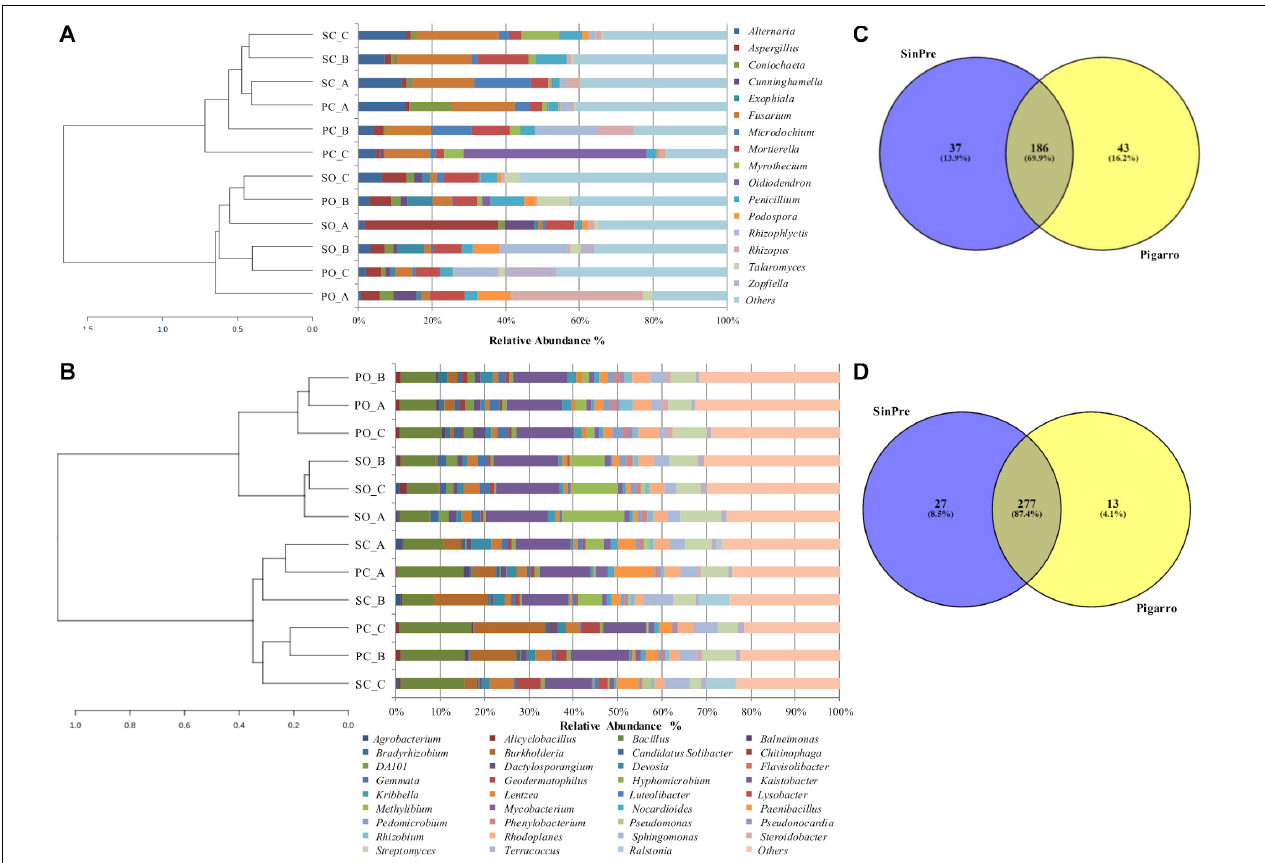
FIGURE 2 | Relative abundance of different fungal (A) and bacterial (B) genera in the soil rhizosphere in both populations representing the genera showing more than 1% relative abundance of all reads. The genera representing less than 1% of the total reads are grouped into “Others.” Venn diagrams showing the common and exclusive fungal (C) and bacterial (D) genera of the rhizosphere of the maize populations “SinPre” and “Pigarro.” PC_A , “Pigarro” conventional plant A; PC_B , “Pigarro” conventional plant B; PC_C , “Pigarro” conventional plant C; PO_A , “Pigarro” organic plant A; PO_B , “Pigarro” organic plant B; PO_C , “Pigarro” organic plant C; SC_A , “SinPre” conventional plant A; SC_B , “SinPre” conventional plant B; SC_C , “SinPre” conventional plant C; SO_A , “SinPre” organic plant A; SO_B , “SinPre” organic plant B; SO_C , “SinPre” organic plant C.